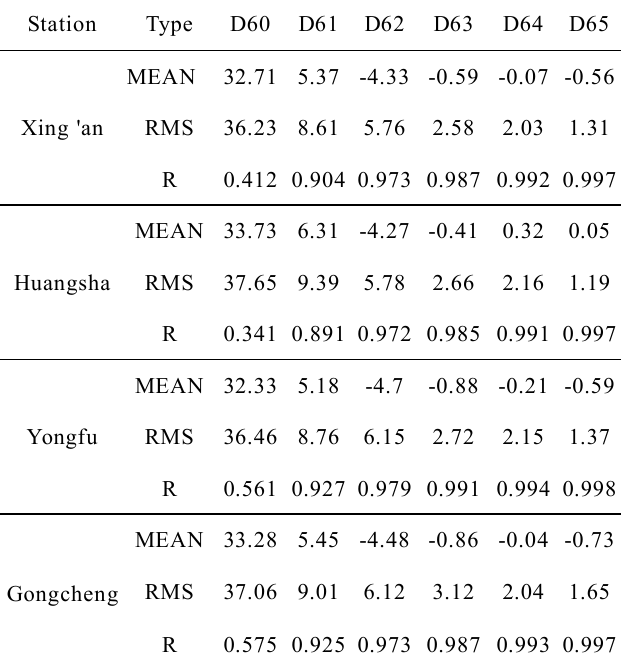
Table 2 Determination of the optimal number of